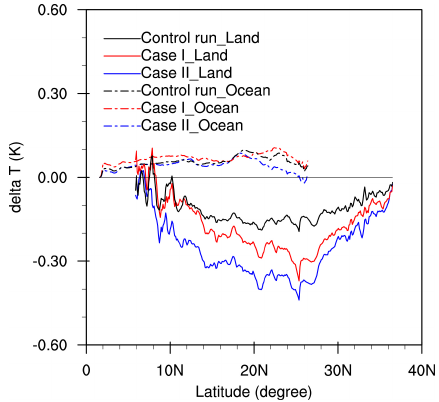
Figure 3. Changes in surface air temperature (K) due to aerosol radiative effects for three model